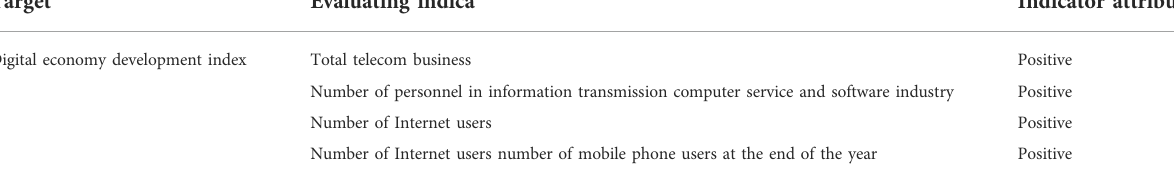
TABLE 1 Measurement system of development level of the digital economy.